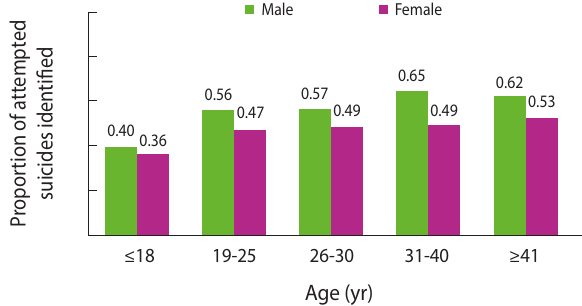
Figure 1. Estimated proportion of attempted suicides by sex and age